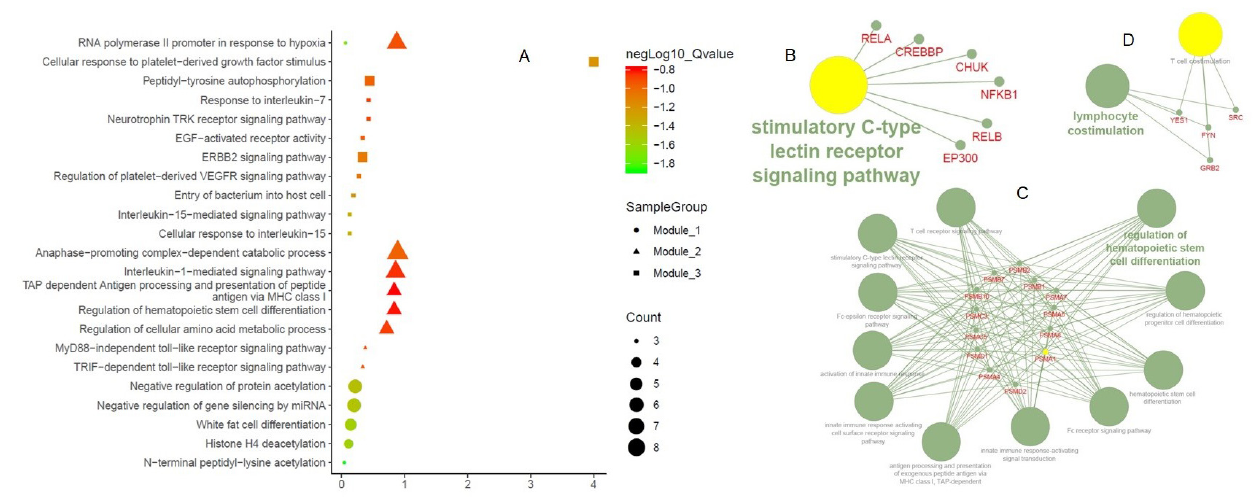
Figure 4. Functional enrichments of the Walk trap modules. ( A ) Biological process terms of three different modules; Immunological terms of ( B ) Module-1; ( C ) Module-2; ( D ) Module-3.